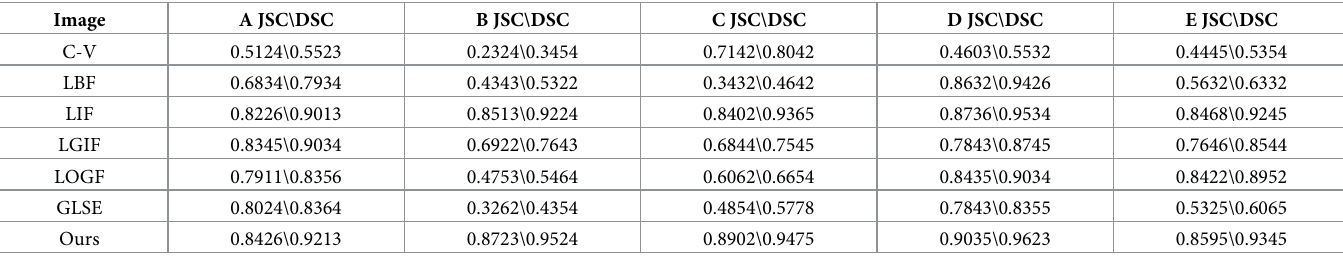
Table 4. The JSC and DSC of different models for Fig 11.